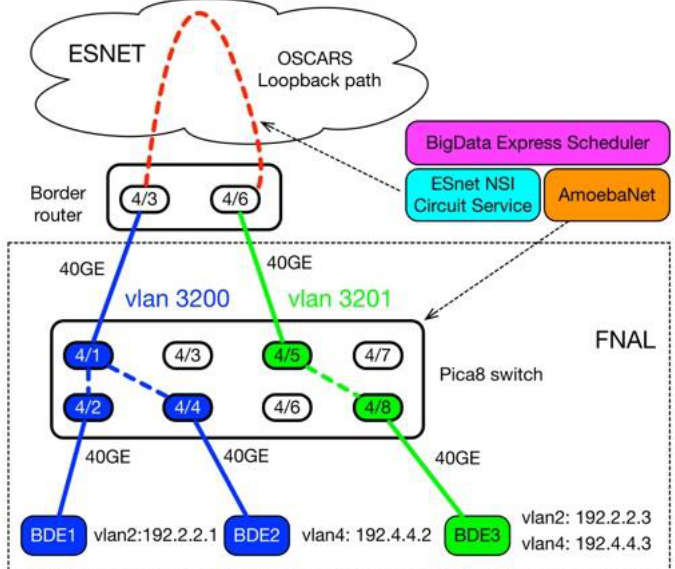
Figure 6. Cross domain data transfer test case .